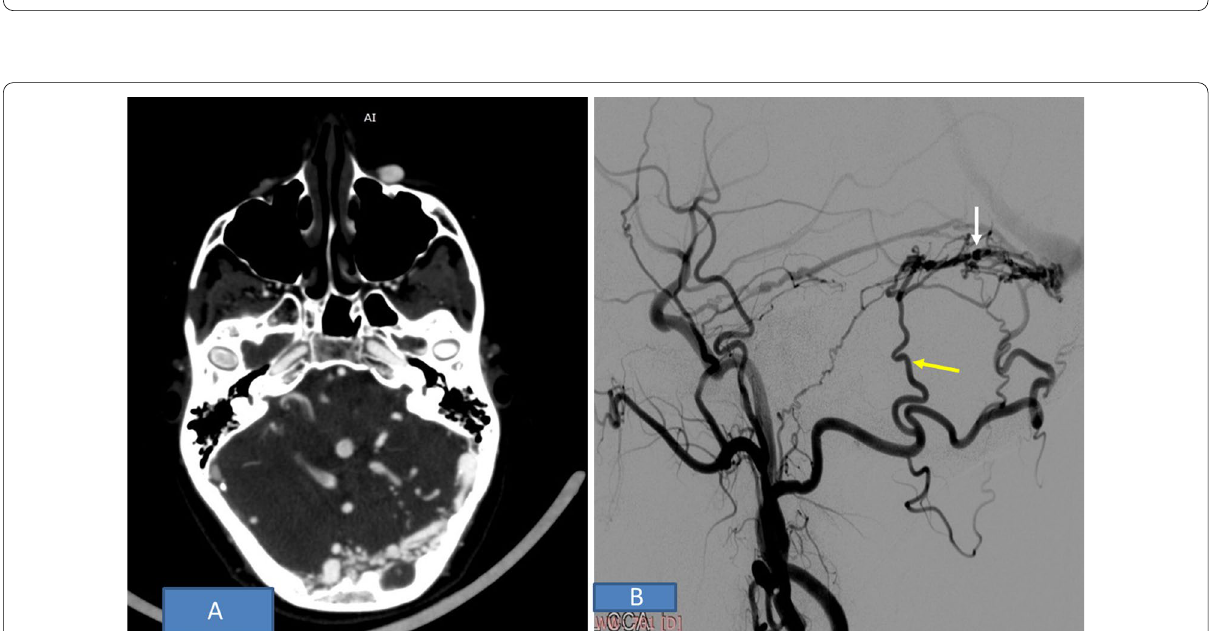
Fig. 4 Dural arteriovenous fistula (dAVF); a Axial MIP image showing the calcifications in torcula and increased vascular channels within the left transverse sinus, b DSA image in lateral view of the same patient showing dAVF (Type 1) in the torcular region (white arrow) with feeders from occipital artery (yellow